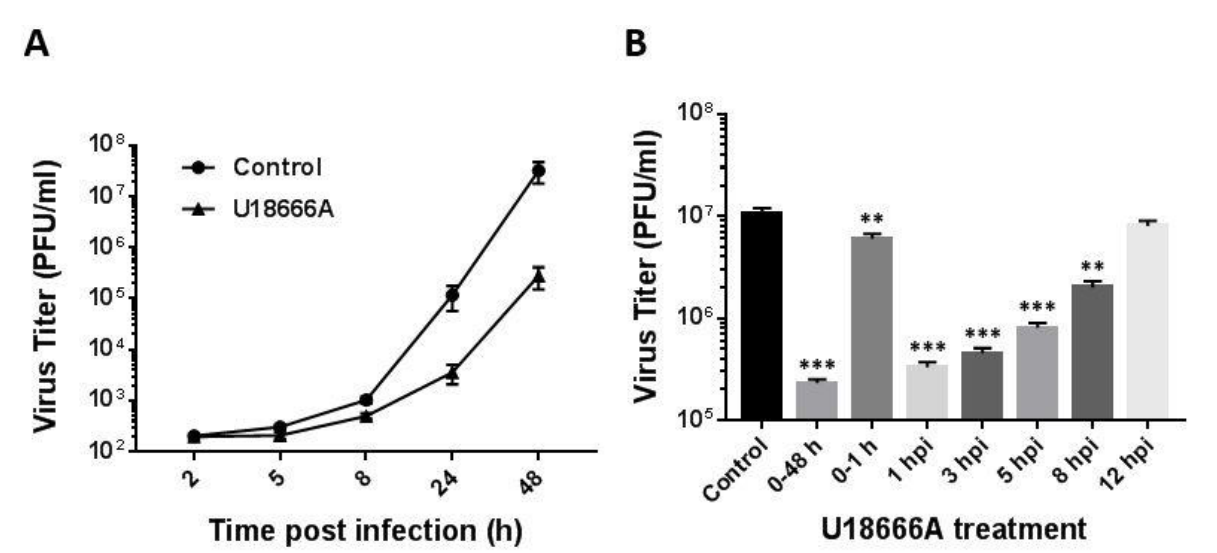
Figure 3. Effects of U18666A on PRV replication. ( A ) PK-15 cells were infected with PRV at an MOI of 5 in the presence of U18666A (5 μg /mL) or DMSO (0.1%, v / v ) as a control. At the indicated times post-infection, virus titer in the culture supernatant was measured by plaque assay. Virus titer is presented in plaque-forming units (PFU)/mL. Data are mean ± SD ( n = 3). ( B ) PK-15 cells were infected with PRV at an MOI of 5 and U18666A (5 μg /mL) was added at the indicated times during or after infection. Treatment with DMSO (0.1%, v / v ) was included as a control. Virus titer in the culture supernatant was determined by plaque assay at 48 h post-infection. Data are mean ± SD ( n = 3). ** p < 0.01; *** p < 0.001.